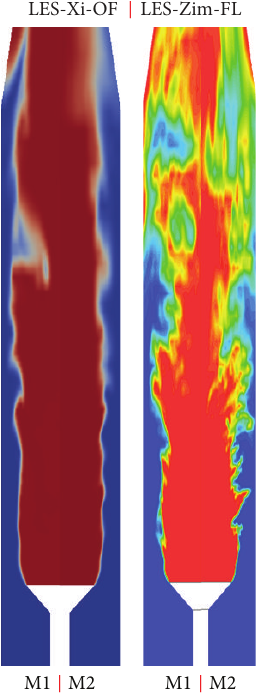
Figure 17: Instantaneous temperature field with OpenFOAM and Fluent